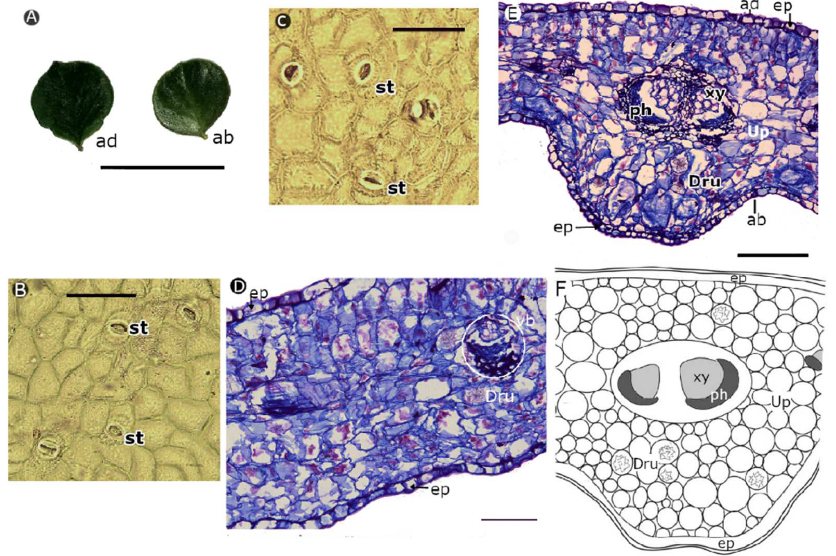
Figure 6. Morpho-anatomy of leaves of Pereskia guamacho [( C – E ): optical microscopy, sections stained with basic fuchsin and astra blue]. ( A ) Leaves, ( B ) adaxial side, ( C ) abaxial side, ( D ) foliar blade, ( E ) midrib, and ( F ) diagram of midrib organization. (ab: abaxial; ad: adaxial; dru: druses; ep: epidermis; ph: phloem; st: stomata; xy: xylem; up: undifferentiated parenchyma; vb: vascular bun- dle). Scale bars: ( A ) = 5 cm; ( B – D ) = 0.1 mm; ( E ) = 0.2